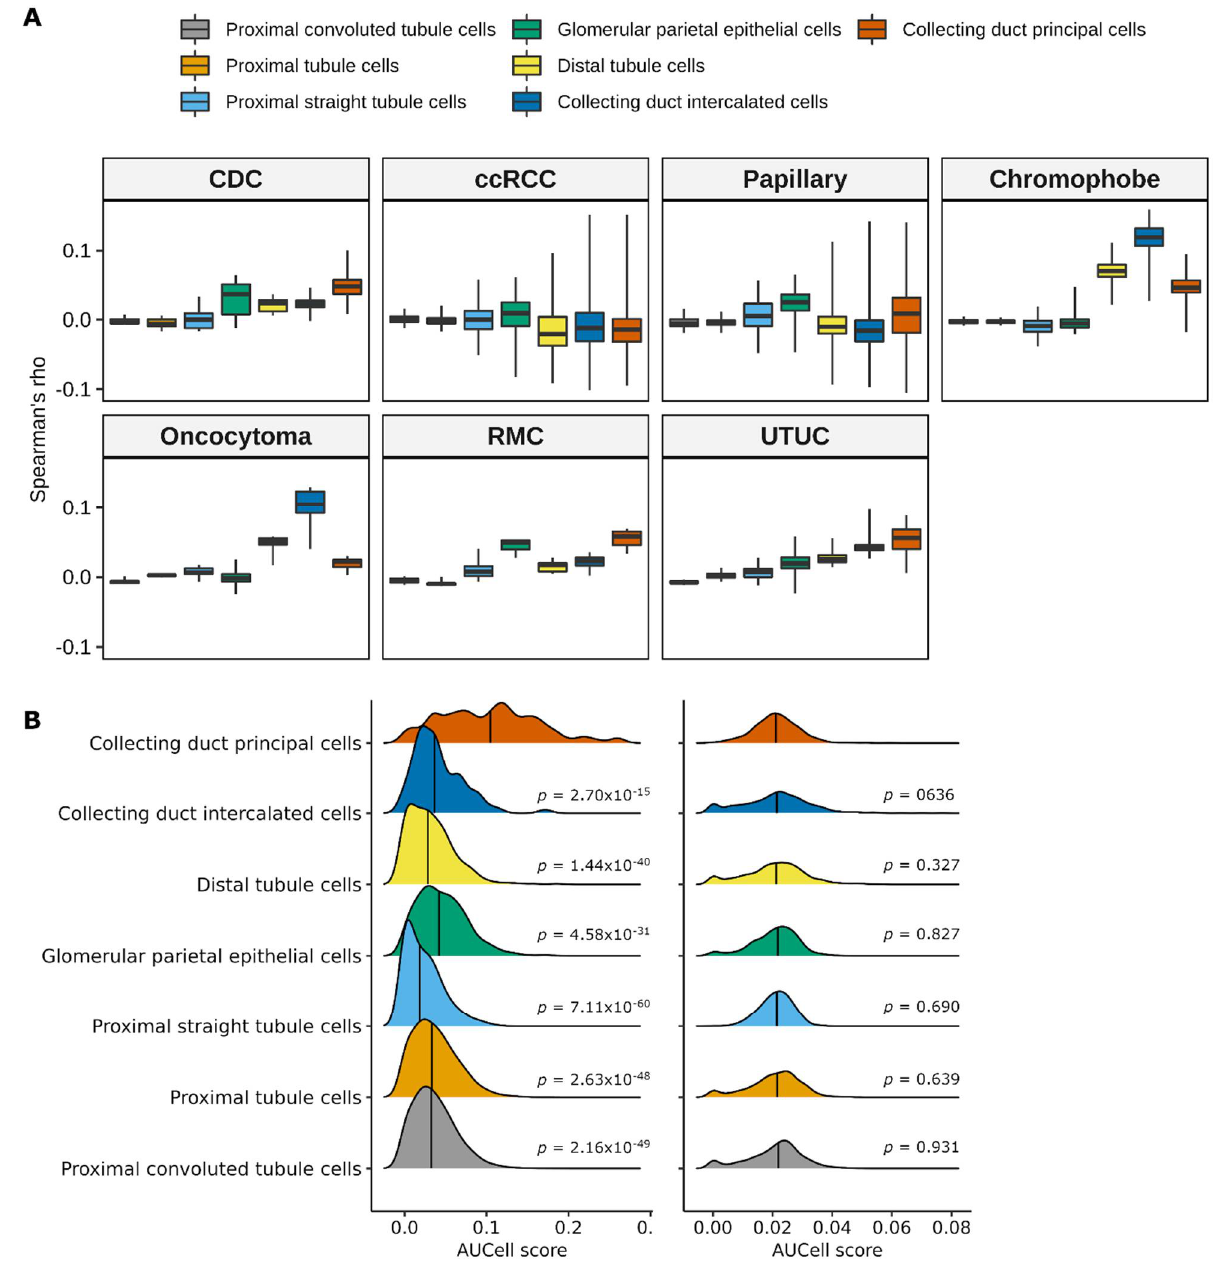
Figure 5. Cell-of-origin of CDC tumors. ( A ) Boxplot showing the correlation between bulk gene expression profiles of different kidney tumor histologies and single-cell transcriptomics data of normal kidney cell types from dataset GSE131685; ( B ) distribution of the single-sample AUCell scores of the CDC-specific INT signature (left column) in each kidney cell type from dataset GSE131685. Null distribution of 1000 random gene sets of the same size of the CDC-specific INT signature is reported in the right column. p -values by Wicoxon rank-sum test between each cell type and collecting duct principal cells.